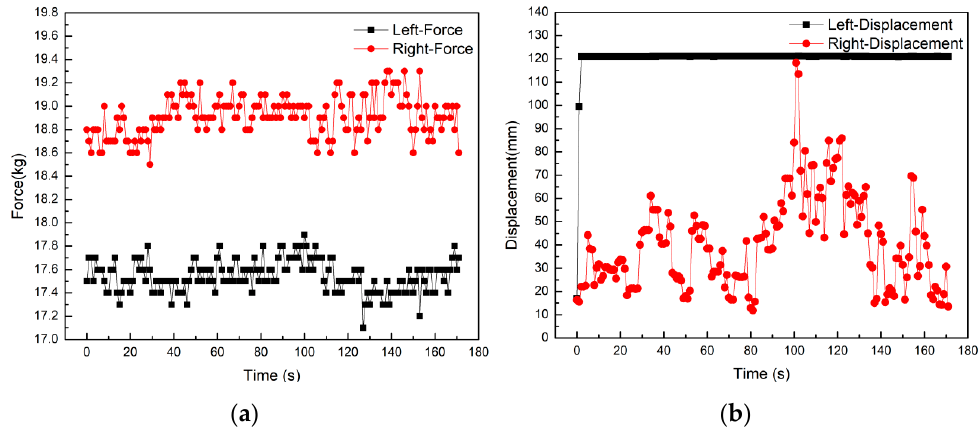
Figure 21. ( a ) Force curve of in situ right steering; ( b ) displacement curve of in situ right steering.